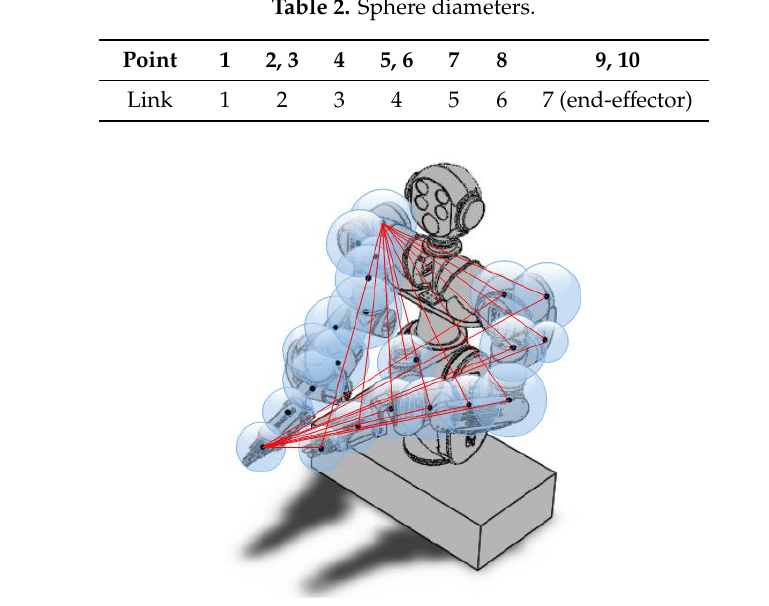
Figure 7. Collision model of the robot used to calculate the distances of the collision model. The red lines represent the distance from the two points on the right arm to all points on the left arm.